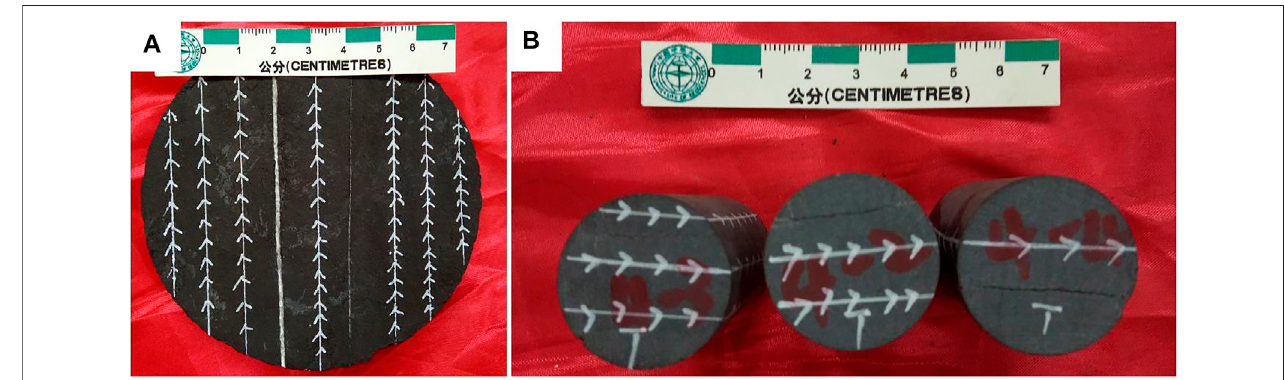
FIGURE 3 | Core samples for paleomagnetic orientation experiments; marker lines are parallel to the target fracture. (A) Original core sample; (B) Cylindrical samples after